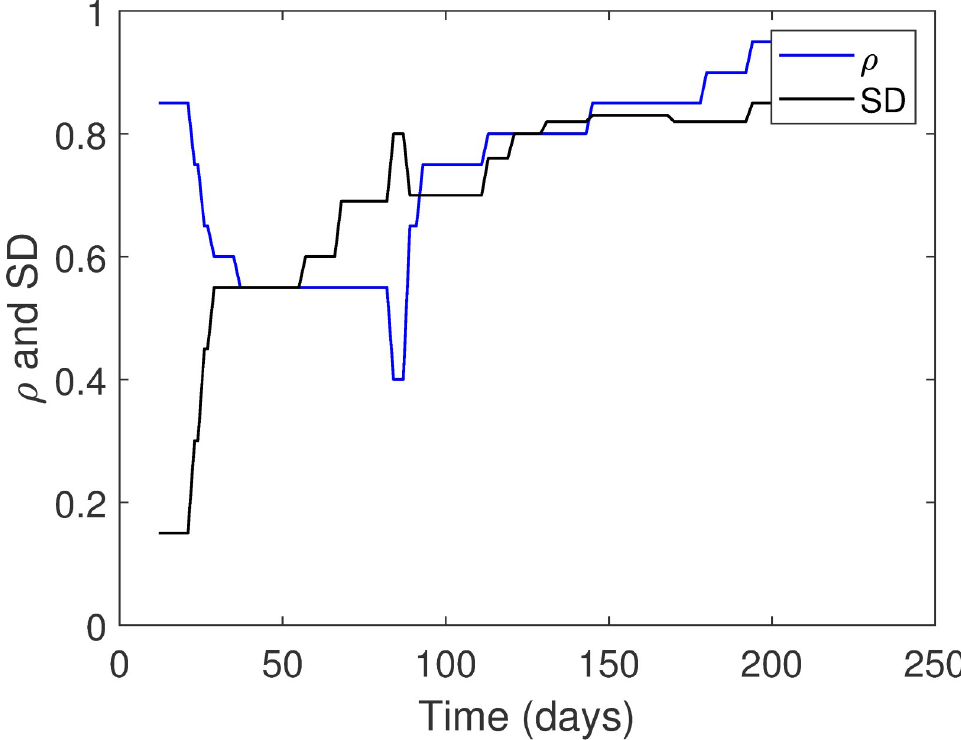
Fig 2. Time variation of the parameters: The lockdown, ρ , and the social distancing, SD .